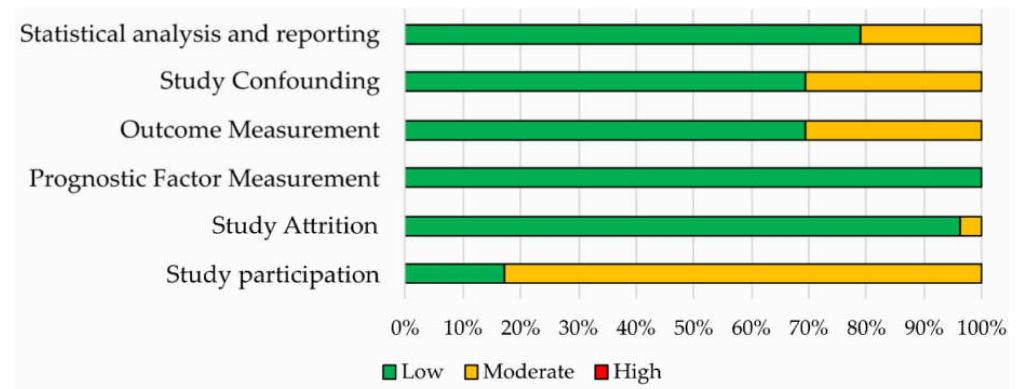
Figure 3. Risk of bias assessment according to the six domains of the Quality in Prognostic Studies (QUIPS) tool for the 52 studies included in the systematic